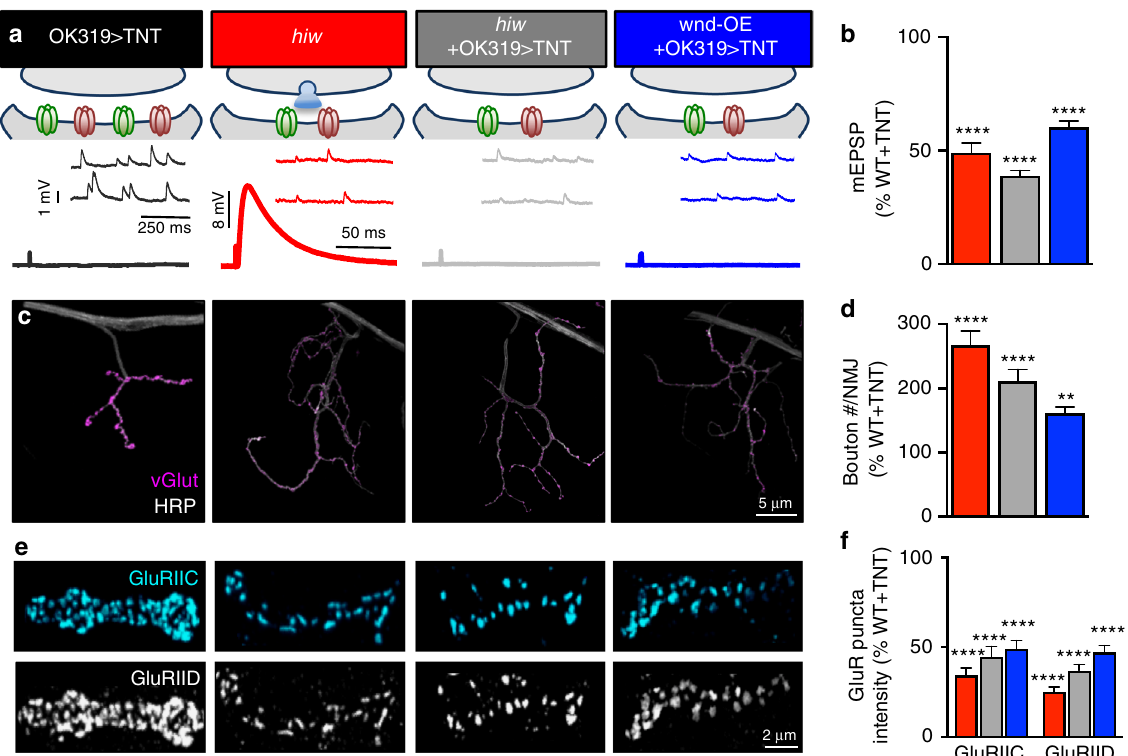
Fig. 3 Presynaptic Wnd signaling induces GluR remodeling independently of evoked neurotransmitter release. a Schematic and representative traces of NMJs expressing tetanus toxin in otherwise wild type backgrounds (OK319>TNT: w ; OK319-Gal4 / + ; UAS-TNT / + ), in hiw mutants ( hiw + OK319>TNT: hiw Δ N ;OK319-Gal4 / + ; UAS-TNT / + ), and in wnd-OE (wnd-OE + OK319>TNT: w ; OK319-Gal4 / UAS-wnd ; UAS-TNT / + ). b Quanti fi cation of mEPSP amplitude in the indicated genotypes normalized to OK319>TNT values. Note that reduced mEPSP values persist in hiw and wnd-OE despite the absence of evoked activity. Representative NMJs of the indicated genotypes immunostained ( c ) and quanti fi ed ( d ) with antibodies against the synaptic vesicle marker vGlut (magenta) and neuronal membrane marker HRP (white). The exuberant synaptic overgrowth characteristic of hiw and wnd-OE also persists in the absence of evoked activity. e Representative images of boutons immunostained with antibodies against the common postsynaptic glutamate receptor subunits GluRIIC and GluRIID. f Quanti fi cation of individual GluR puncta intensity normalized to OK319>TNT. Receptor levels in hiw and wnd-OE are reduced despite the absence of evoked activity. Error bars indicate ± SEM. One-way analysis of variance (ANOVA) test was performed, followed by a Tukey ’ s multiple-comparison test. ** p 0.001; **** p